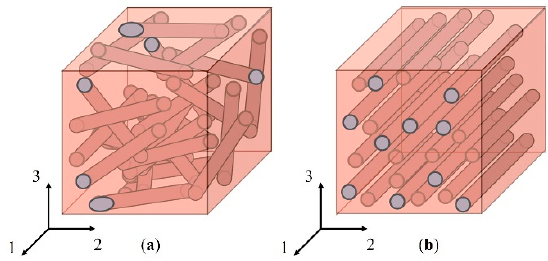
Figure 4. Orientation of a fiber population within a volume: ( a ) randomly oriented fibers and ( b ) aligned fibers.